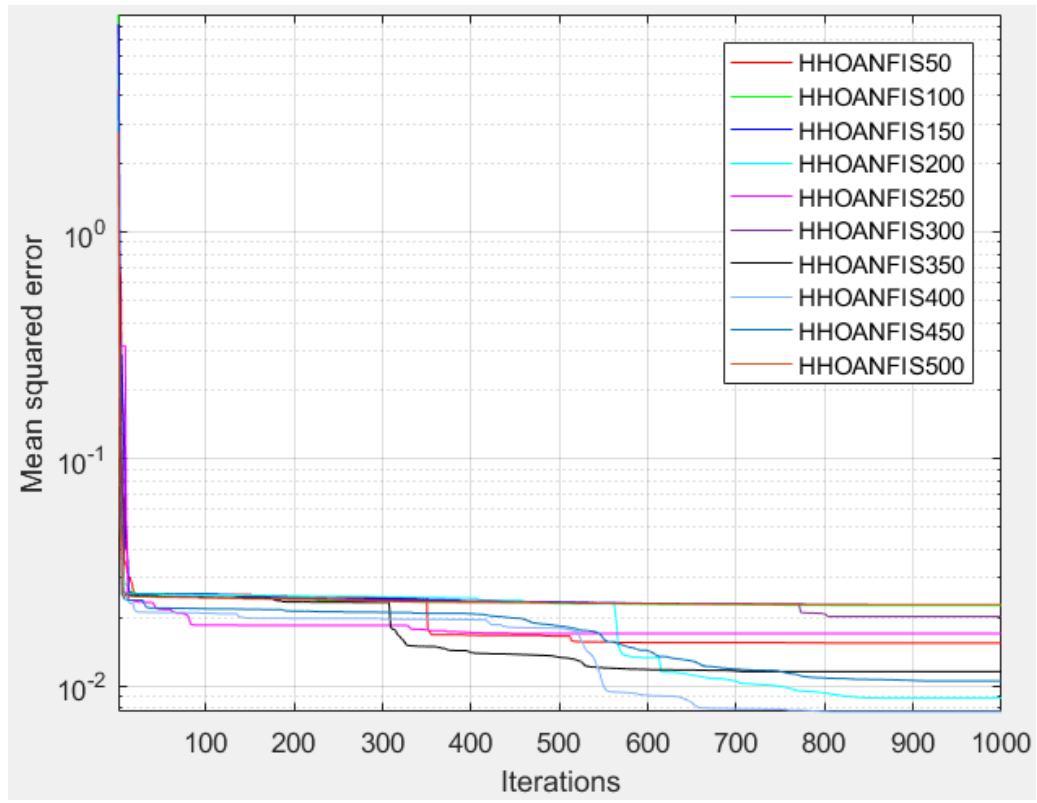
Figure 4. Variation of mean squared error versus iterations for the HHO − ANFIS. Table 2. The network results for the HHO − ANFIS having different swarm